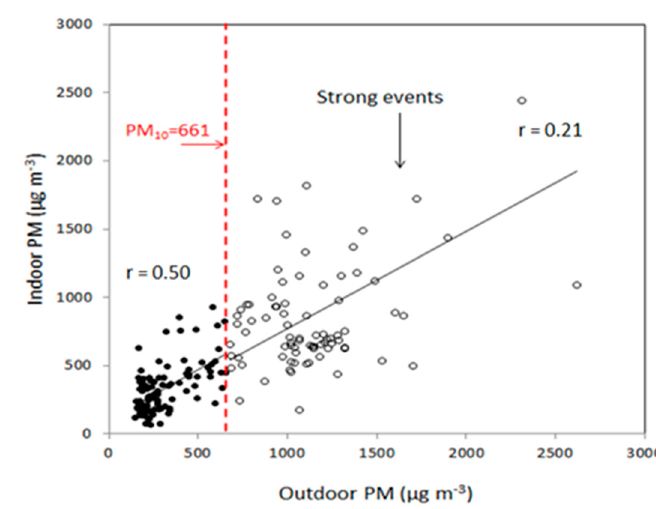
Figure 6. Correlation between outdoor and indoor PM 10 concentrations during the different PM levels. Strong dust storms are distinguished by their PM levels that exceed the calculated threshold of 661 µg m − 3 .